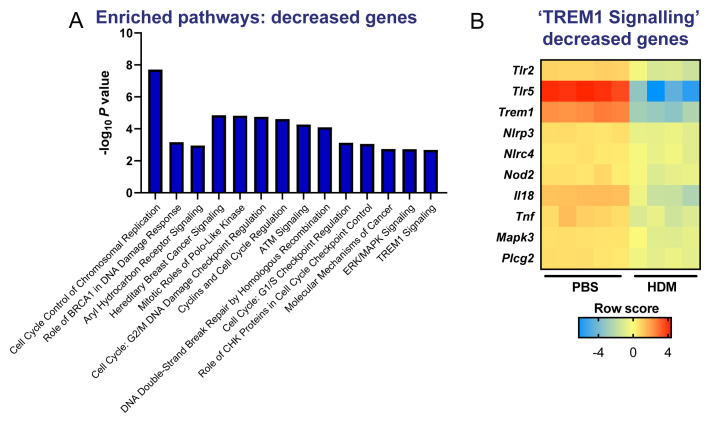
Decreased expression of a subset of innate immune function genes in AMs
HDM.(
A) Highly enriched pathways for total decreased genes in AMs
HDM (
B) Decreased expression of a subset of ‘TREM1 Signalling’ pathway genes in AMs
HDM compared to control AMs. Bar plot shows canonical pathway names and inverse enrichment Fisher’s exact
P values. Heatmap shows row-centred gene expression values (N=5 mice, PBS; N=4 mice, HDM).